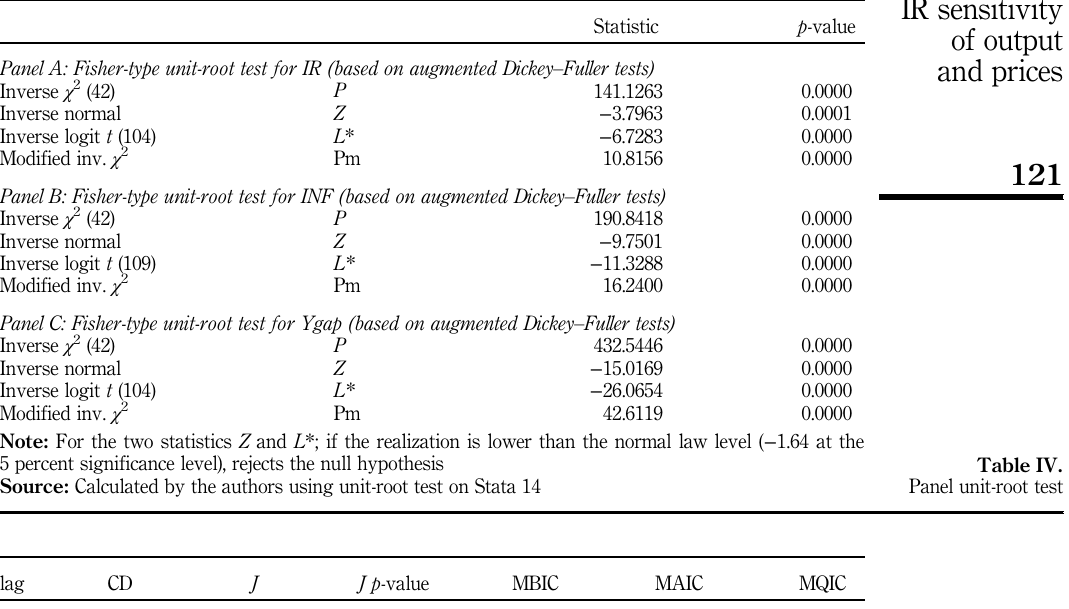
Table V. The result of lag length selection criteria